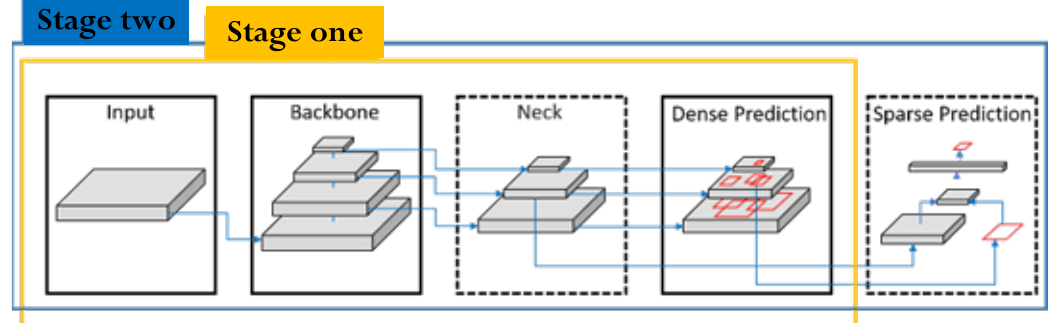
Figure 13. Schematic diagram showing the YOLO v4 object detection